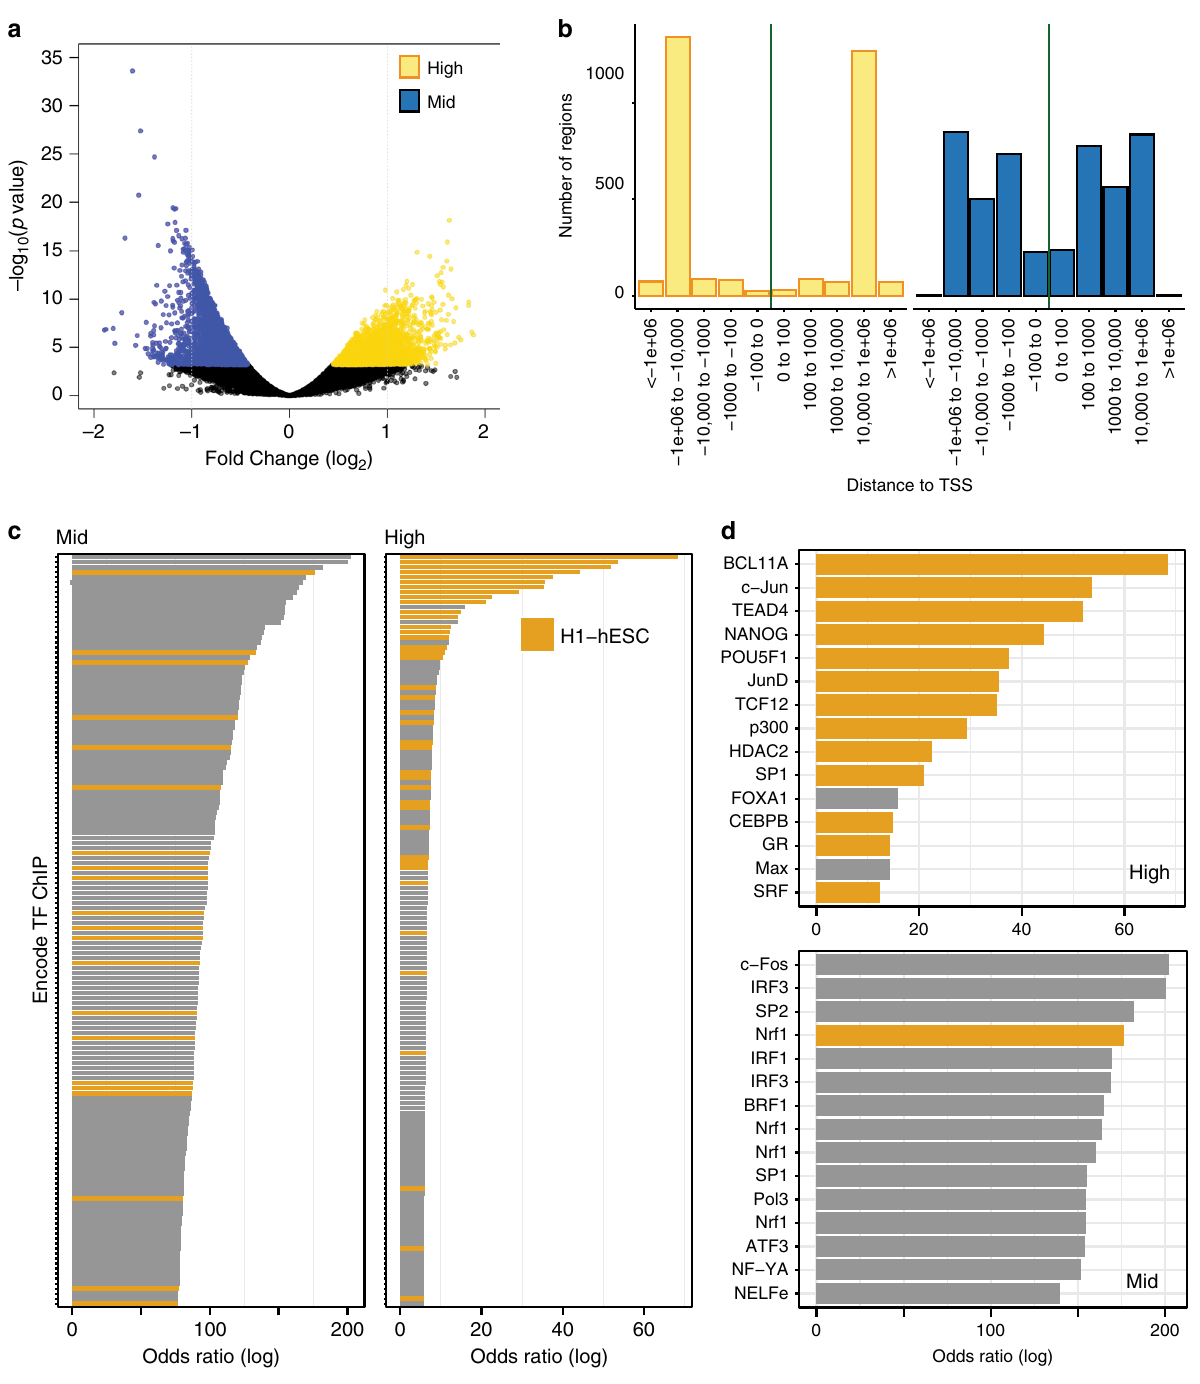
Fig. 7 Landscape of accessible chromatin differentiates stem cell populations. a Volcano plot showing signi fi cant differences in DNA accessibility as measured using ATAC-seq between GCTM-2 high CD9 high EPCAM high (yellow) and GCTM-2 mid CD9 mid (blue) populations (FDR < 0.01). Vertical lines indicate twofold difference. b Distribution of signi fi cantly different open chromatin regions plotted as distance from TSS. c Bar chart of the top 150-log odds ratios for overlap of differentially open chromatin regions in the GCTM-2 mid CD9 mid (left) and GCTM-2 high CD9 high EPCAM high (right) populations compared with all ChIP-seq data for all cell types in the ENCODE TF dataset. Orange indicates ChIP data from the human ESC cell line H1. d Similar to c showing to 15 highest log odds ratios for overlap. Names of each TF antibody used for ChIP are indicated on the